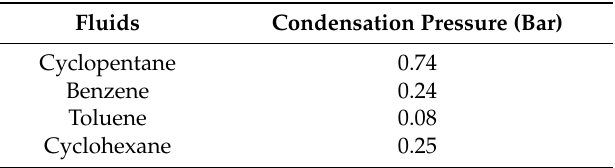
Table 6. ORC condensation pressure